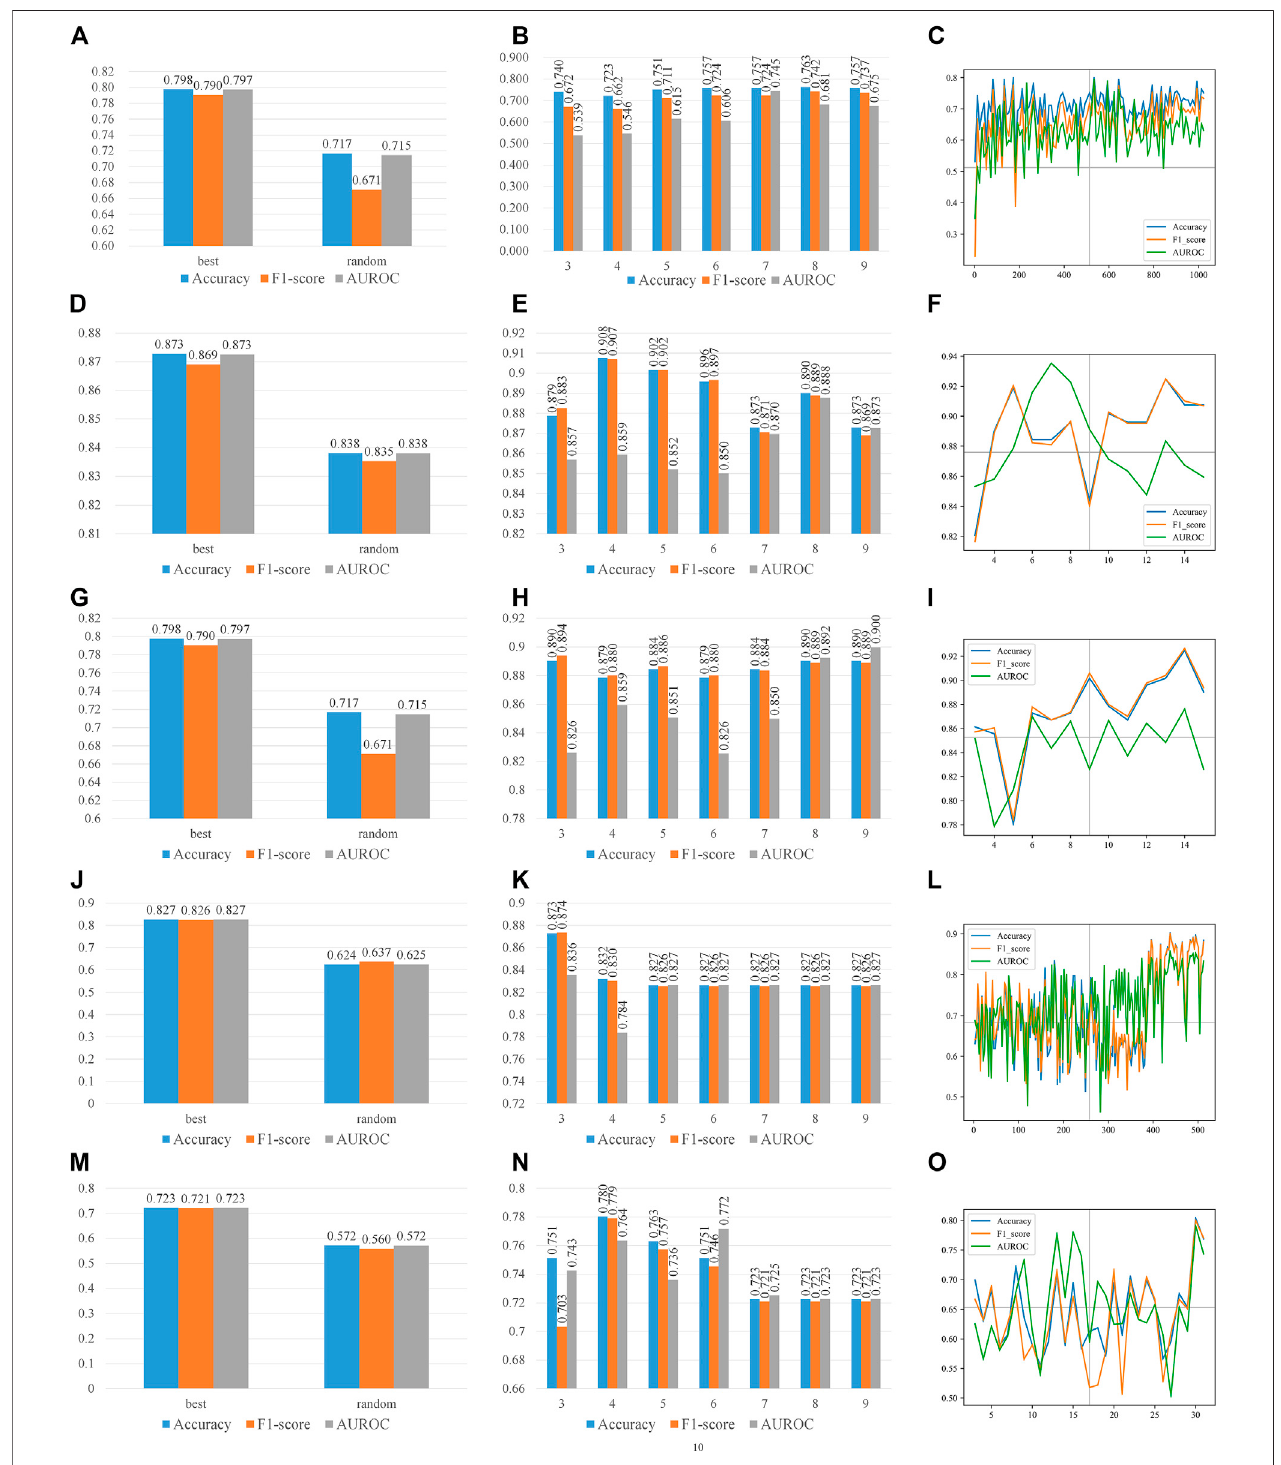
FIGURE 4 | Parameter effects on CART with different types of features. Parameters of CART are scanned. The accuracy, F1-score, and AUROC are presented in each panel. (A) , (B) , and (C) arescanning CART parameters S , D , and M on k -mer features, respectively, and (D) , (E) , and (F) are scanning CARTparameters S , D , and M onmismatchfeatures,respectively; (G) , (H), and (I) are scanning CART parameters S , D ,and M onsubsequence features, respectively; (J) , (K) , and (L) arescanning CART parameters S , D , and M on PseDSSPC features, respectively; (M) , (N) , and (O) are scanning CART parameters S , D , and M on the triplet features, respectively. The best parameter for k -mer features is S = ‘ best ’ , D = 8, and M = 490. The best parameter for mismatch features is S = ‘ best ’ , D = 4, and M = 13. The best parameter for subsequence features is S = ‘ best ’ , D = 3, and M = 14. The best parameter for PseDSSPC features is S = ‘ best ’ , D = 3, and M = 460. The best parameter for the triplet features is S = ‘ best ’ , D = 4, and M = 30.